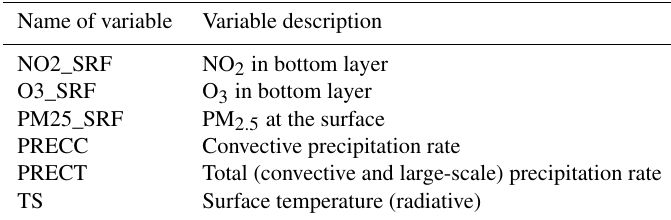
Table A5. 1-hourly instantaneous output from the atmospheric model in ARISE-SAI-1.5 simulations and five additional SSP2–4.5 CESM2(WACCM6) simulations. None of the above output is contained in the first five ensemble members of CESM2(WACCM6) SSP2–4.5